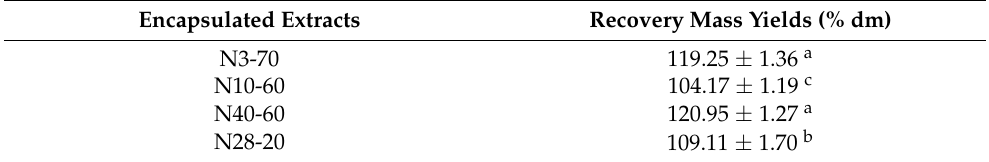
Table 1. Recovery mass yields (% on dry matter, dm) of the spray-drying encapsulation process. Values reported as mean ± standard deviation. Values reported in different lowercase letters are significantly different ( p <